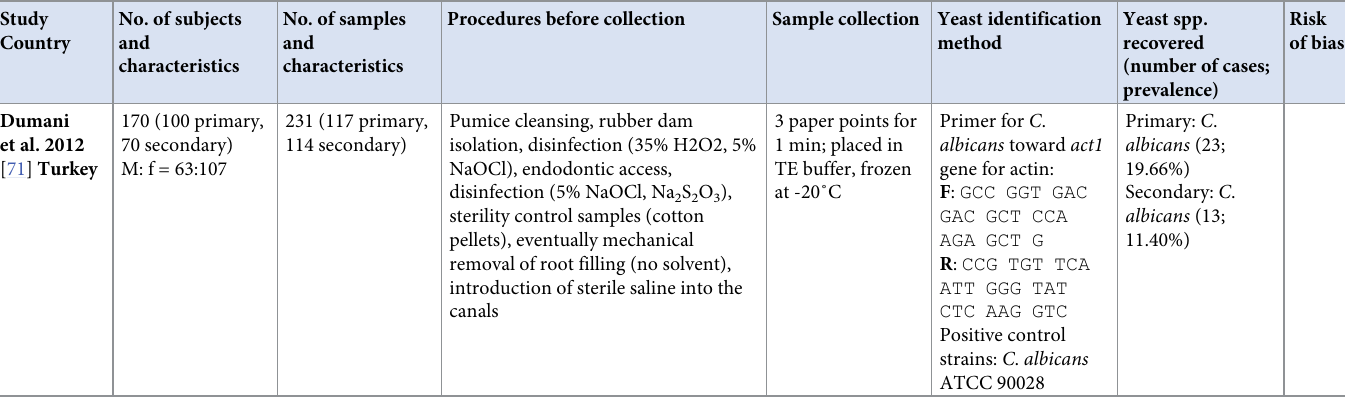
Table 6. Characteristics of the included studies assessing prevalence of yeasts in both primary and secondary endodontic infections, using molecular